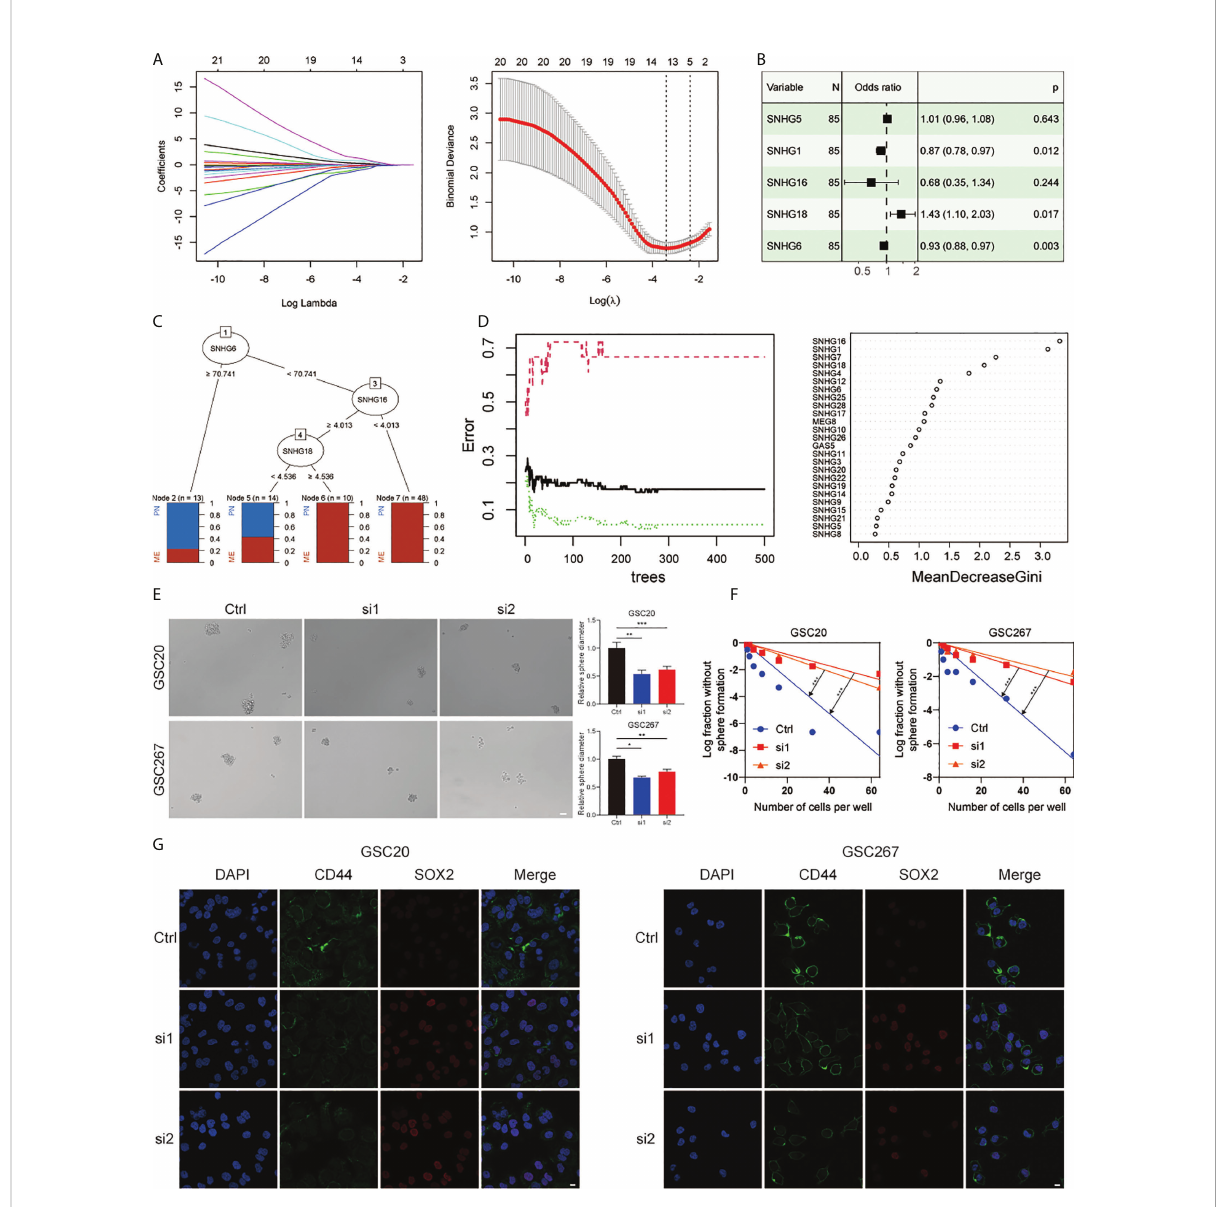
FIGURE 2 The role of SNHG18 among the SNHG family in GSCs. (A) LASSO coef fi cient pro fi les of 25 SNHGs and the optimal penalization coef fi cient ( l ) via 10-fold cross validation based on partial likelihood deviance. (B) Multiple logistic regression analysis of the remaining fi ve SNHGs selected by LASSO. (C) A classi fi cation tree was built to optimize the GBM subtype strati fi cation. (D) Random-forest algorithm was utilized to screen for the most important SNHG correlated with GBM subtype. ntree: number of decision trees. (E) Cell spheres formation assay of GSC20 as well as GSC267 transfected with si-SHNG18, or si-Ctrl and column plot represented the relative spheres diameter (scale bar=50 m m). (F) Limiting dilution assay for GSC20 as well as GSC267 transfected with si-SHNG18 or si-Ctrl. (G) IF assay exhibited the level of CD44 and SOX2 in GSC20 and GSC267 transfected with si-SHNG18 or si-Ctrl (scale bar=15 m m). All data are presented as the means ± SD, ns, P > 0.05, *P < 0.05, **P < 0.01, ***P <